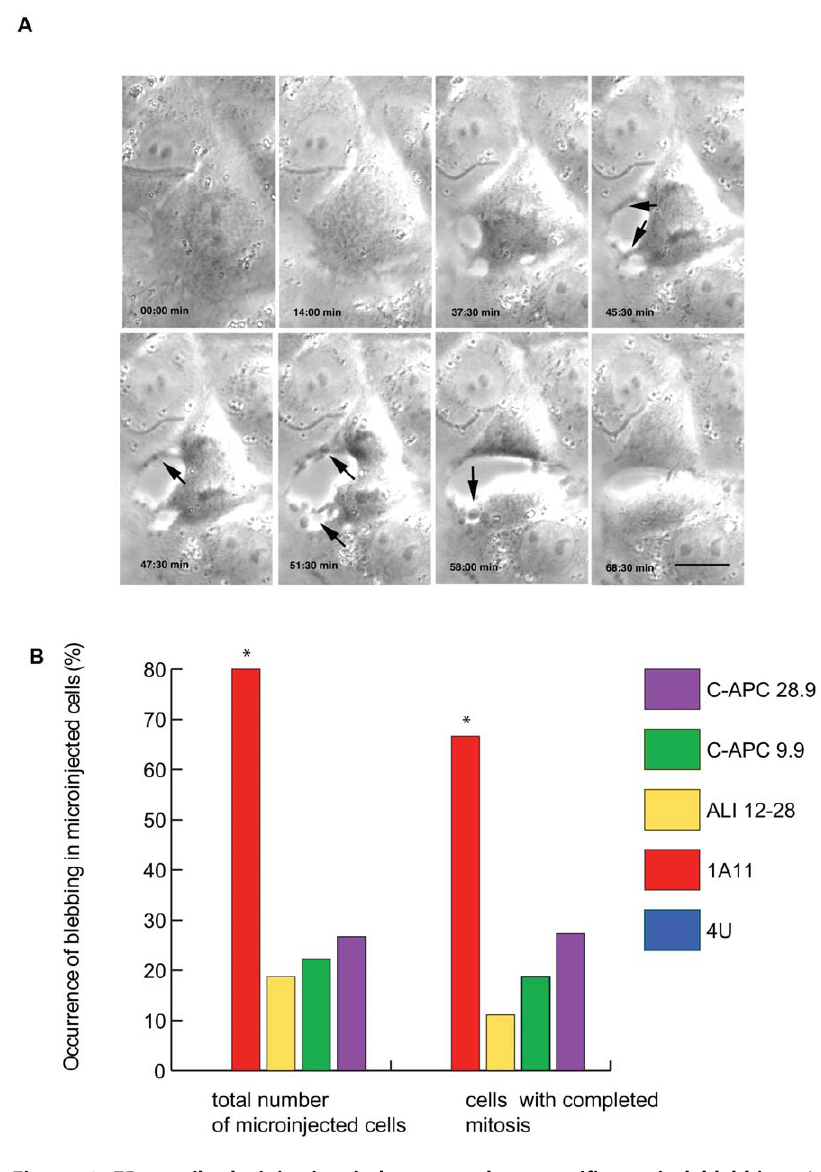
Figure 6. EB1 antibody injection induces anaphase-specific cortical blebbing. A: Stills from a recording of a representative cell microinjected with 1A11, showing the appearance of cortical blebbing during anaphase (arrows). Scale bar=10 m M. B: The percentage of cells displaying cortical blebbing is first shown as a percentage of the total number of microinjected cells examined (including those that failed to complete mitosis) and then as a percentage of microinjected cells that successfully completed mitosis. In both cases a significantly higher proportion of cells microinjected with antibody 1A11 displayed blebbing (p , 0.005 and p , 0.05). 1A11-induced blebbing was only seen during anaphase whereas a lower level of blebbing was noted throughout mitosis in cells injected with anti-APC antibodies (see Figure 2 panels D and E for examples of blebbing in metaphase cells injected with anti-APC antibodies). Blebbing was not observed in mitotic cells injected with the non-specific IgG 4 U (zero entry in first column). Significant results are indicated by an asterisk. (4 U, n=16 for total number of microinjected cells, n=12 for cells with completed mitosis; 1A11, n=19 and 11; ALI 12–28 n=16 and 9; C-APC 9.9, n=18 and 16; C-APC 28.9, n=15 and 11). doi:10.1371/journal.pone.0028884.g006 PLoS ONE |